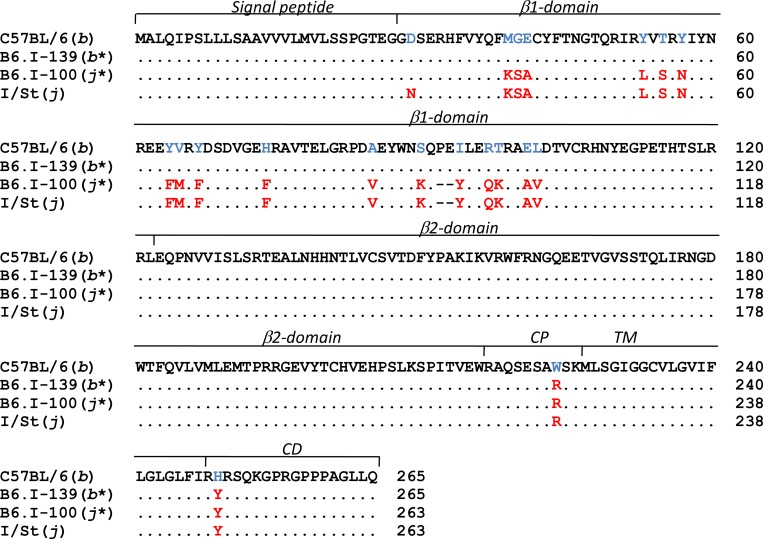
The differences in H2-Ab1 AA sequences between B6.I-100 and B6.I-139 mice.Protein structure alignment of H2-Ab1molecules. Gene annotations are from UniProt Domain structure http://www.uniprot.org: 1–27 –signal peptide; 28–122 - β1 polymorphic domain; 123–216 - β2 conservative domain; 217–226 –connecting peptide (CP); 227–247 –transmembrane domain (TM); 248–265 –cytoplasmic domain (CD). H2b –H2j AA substitutions are highlighted.